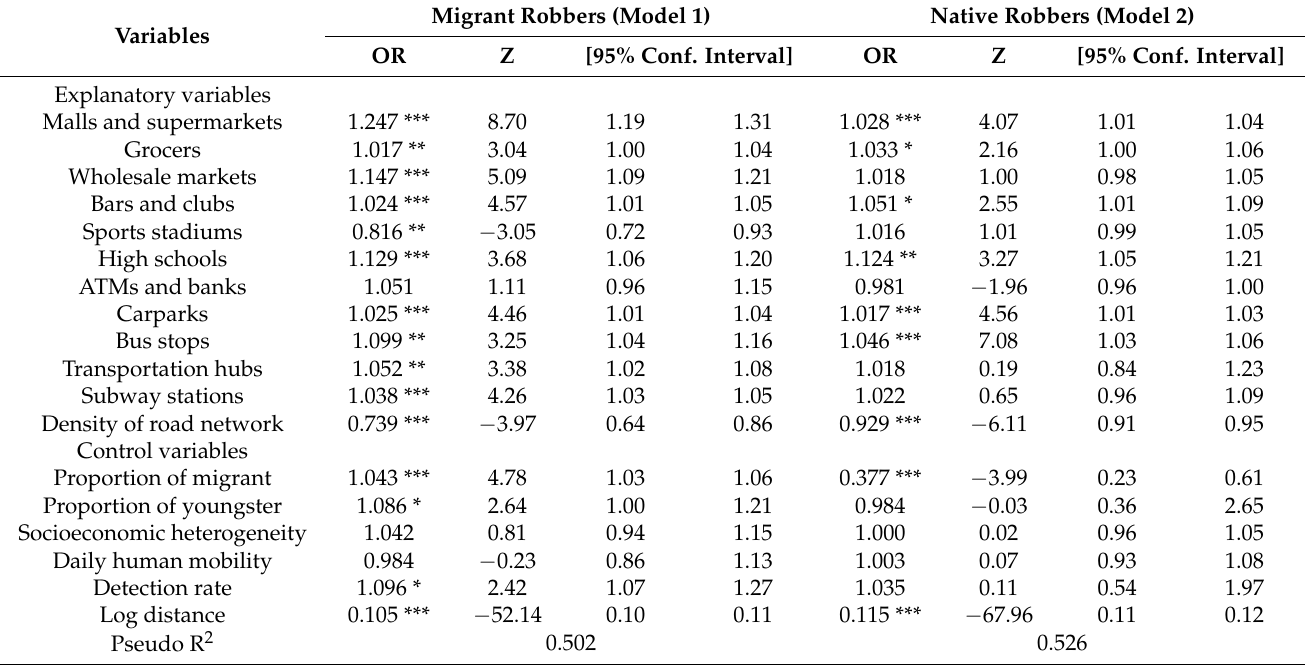
Table 4. Evaluation results of migrant robbers and native robbers in ZG